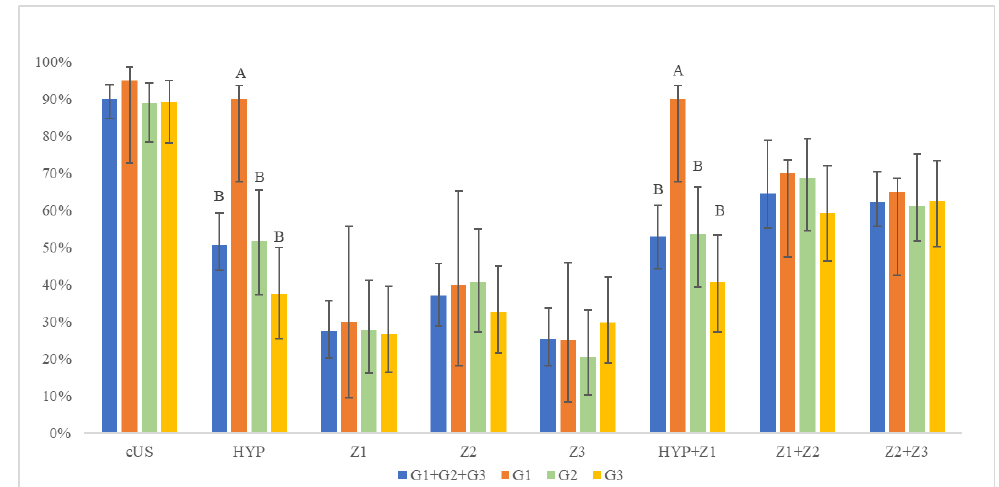
Figure 3. Percentage of true-positive-zones detected with each scan windows in the entire population and groups. cUS: complete liver scan through intercostal spaces; HYP: liver scan through hypochondrium; Z1: liver scan from hypochondrium to 11th intercostal space; Z2: liver scan from 10th to 8th intercostal space; Z3: liver scan from 7th to 5th intercostal space; HYP + Z1: sum of scan in HYP and Z1; Z1 + Z2: sum of scan in Z1 and Z2; Z2 + Z3: sum of scan in Z2 and Z3; G1: weight ≤ 45 kg; G2: 46 kg ≤ weight ≤ 63 kg; G3: weight ≥ 64 kg; G1 + G2 + G3: total population; A, B: percentage with the same letter are not significantly different ( p ≤